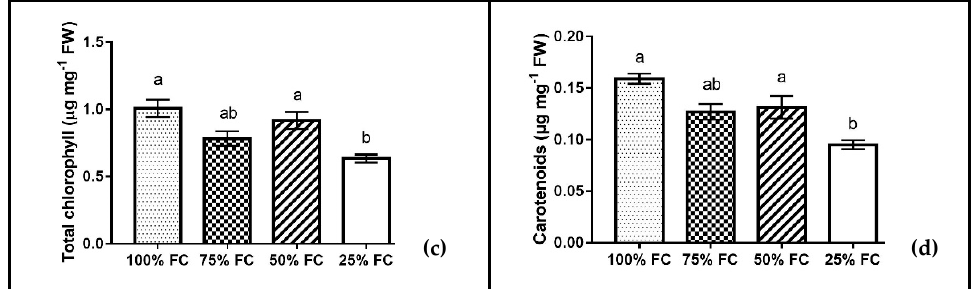
Figure 4. Chlorophyll a ( a ), chlorophyll b ( b ), total chlorophyll ( c ), and carotenoids ( d ) in zinnia plants. Plants were irrigated at field capacity (100% FC) or subjected to drought stress (75% FC, 50% FC, and 25% FC). Mean values ± standard error (S.E) (n = 6). Different letters indicate significant differences among the treatments as determined by Tukey’s test. Table 3. Effects of irrigation treatments on relative water content (RWC, %) and chlorophyll a fluorescence (Fv/Fm) of potted zinnia plants at the end of the experimental period. Plants were irrigated every day. Four treatments were performed: irrigated at 100% (100% FC); light deficit irrigation (75% FC), irrigated at 75% from the 100% FC treatment; medium deficit irrigation (50% FC), irrigated at 50% from the 100% FC treatment and severe deficit irrigation (25% FC), irrigated at 25% from the 100% FC treatment.